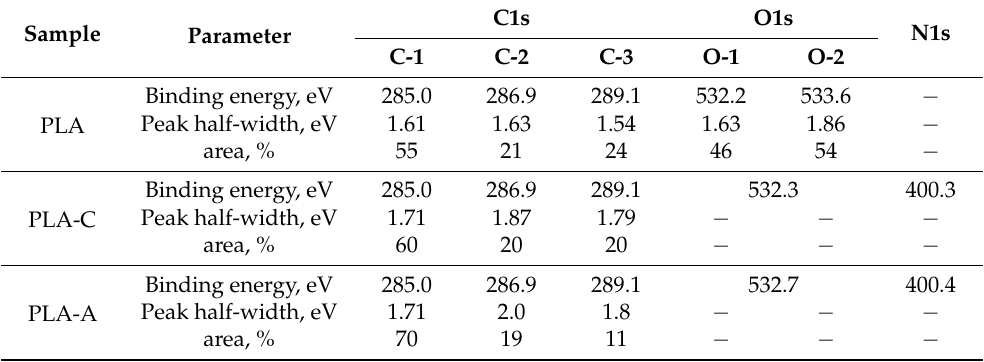
Figure 1. ( a ) PLA structural formula with peak marks and C1s spectra of the films, ( b ) initial, and ( c ) treated at the cathode, or ( d ) at the anode. Table 2. Approximation parameters of high ‐ resolution XPS core ‐ level spectra of the initial and plasma ‐ treated PLA films.